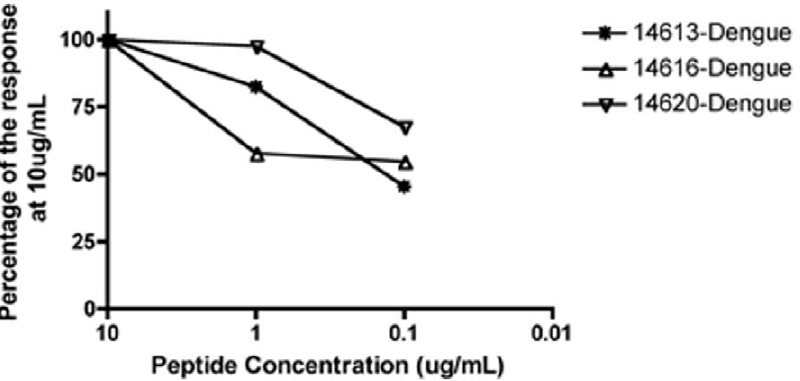
Figure 2. ELISPOT results in 9 mice vaccinated with either A*02:01 dengue peptide pool or YFV 17DD vaccine in A*02:01 mice. Peptides positive at concentration 0.1 m g/mL and greater are shown. Results are depicted as percentage of spot-forming cells/million cells of each peptide at 10 m g/mL. doi:10.1371/journal.pone.0026494.g002 PLoS ONE |